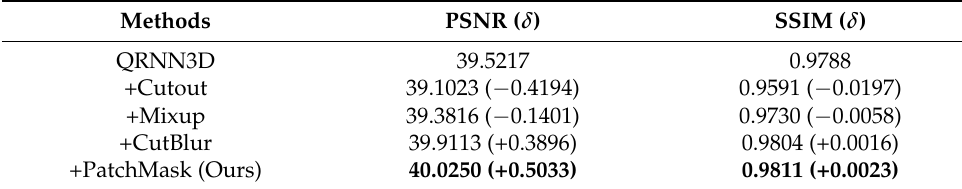
Table 1. Comparison of PSNR and SSIM when using different methods; δ represents an increased value. The baselines used the QRNN3D and ICVL datasets (with Gaussian noise and σ = 50), and these models were trained from scratch. Best scores are highlighted.